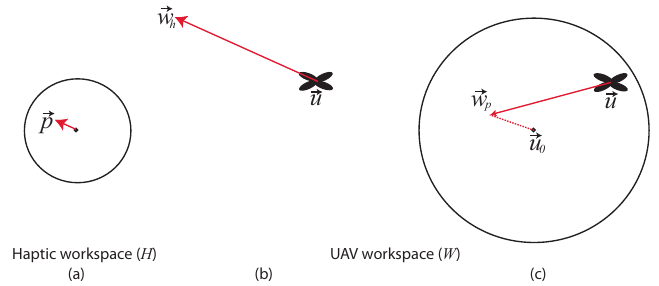
Figure 6. Diagram illustrating the two haptic teleoperation techniques. Haptic workspace on the x , y plane ( a ). Heading-based control technique ( b ); the current displacement (cid:126) p of the haptic device is used to compute a heading direction with respect to the current UAV position. Position to position control technique ( c ); (cid:126) p is used to compute a waypoint with respect to the center of operation (cid:126) u 0